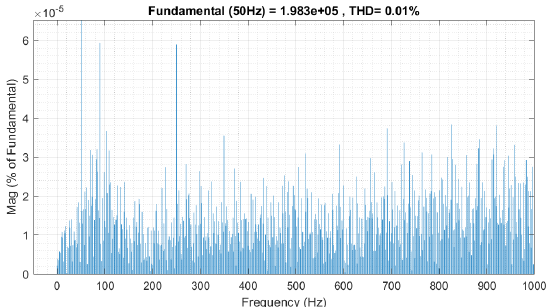
Figure 15. Transformer secondary/rectifier input voltage total harmonic distortion for three EV fast chargers.